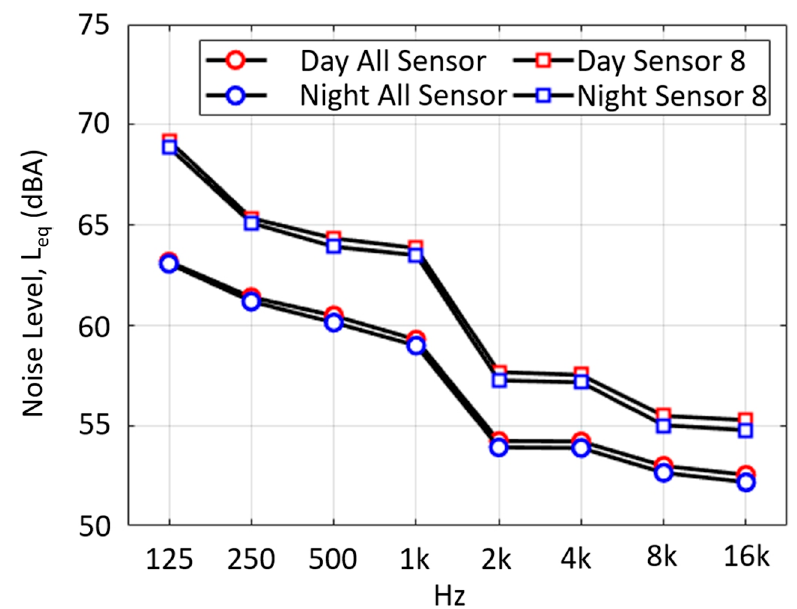
Figure 8. Morning and night noise error data vs. frequency (all sensor avg. vs. sensor 8).